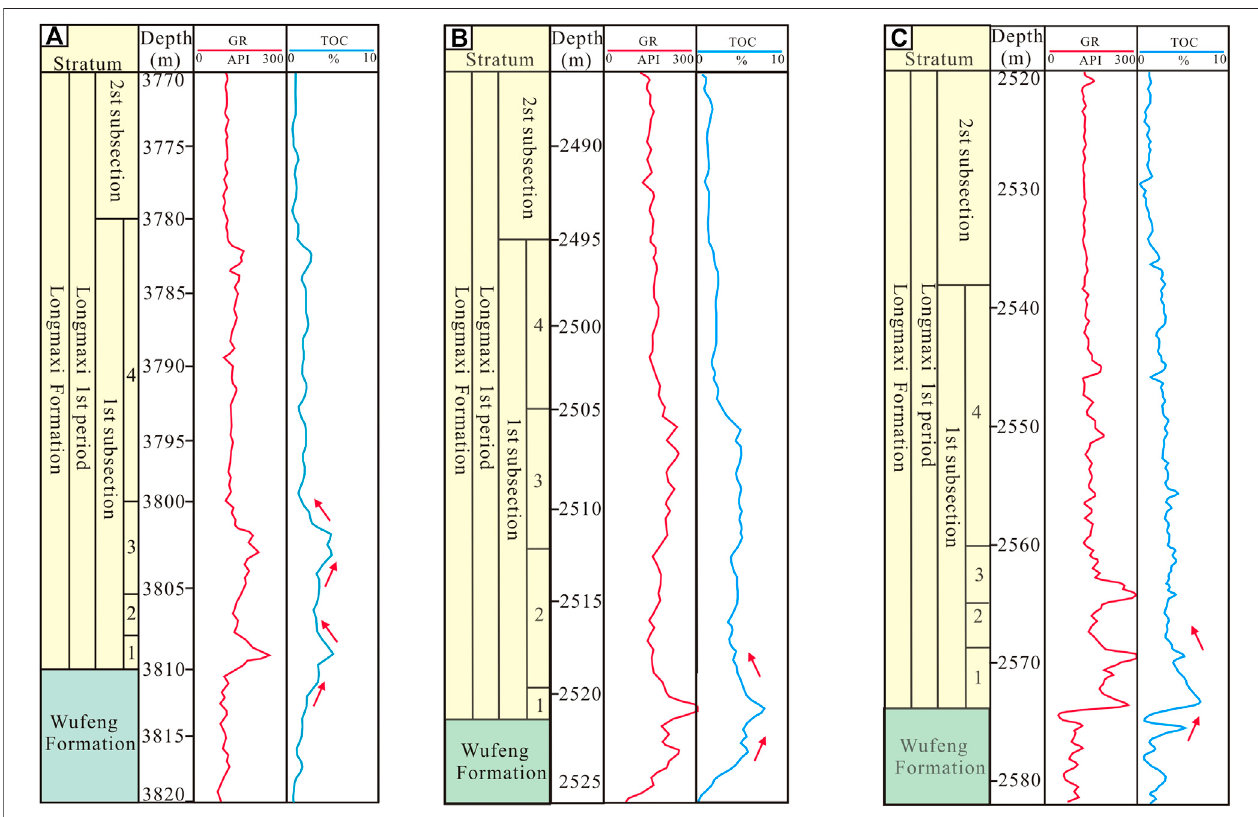
FIGURE 8 | Longitudinal variation in TOC contents of shales in the Wufeng-Longmaxi Formation in southern Sichuan. (A) Well L207, 3,770 m – 3820 m; (B) Well N201, 2,486 m – 2525 m; (C) Well W202, 2,520 m – 2582 m.